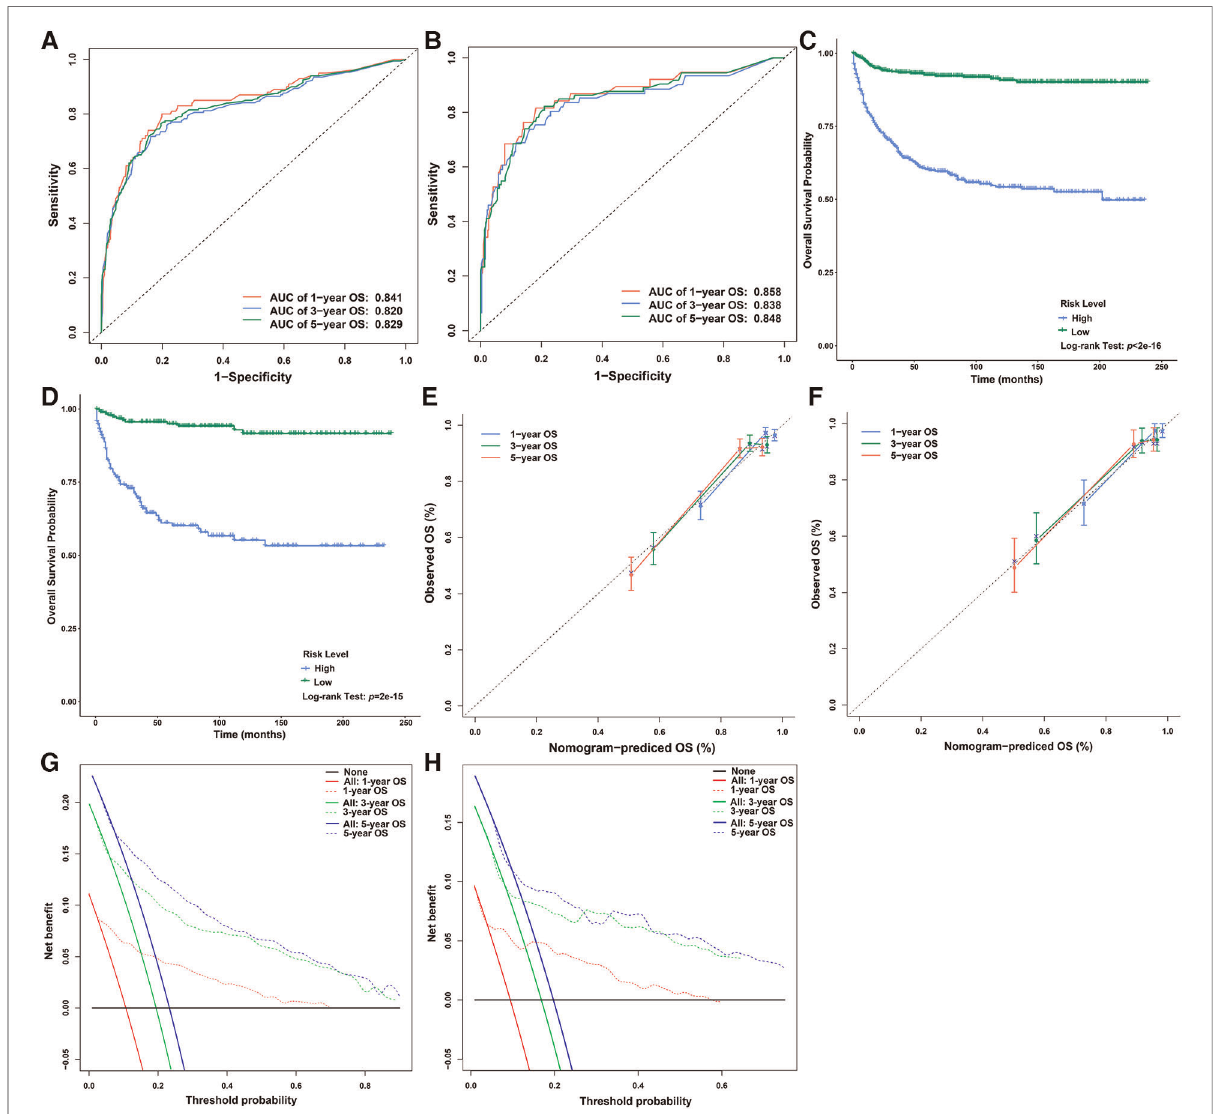
FIGURE 5 Veri fi cation of the nomogram for predicting the OS of children with liver cancer. ( A ) ROC curves of the 1-, 3-, and 5-year OS in the overall dataset. ( B ) ROC curves of the 1-, 3-, and 5-year OS in the testing dataset. ( C ) Survival curves of children with liver cancer between the high- and low-risk score groups in the overall dataset. ( D ) Survival curves of children with liver cancer between the high- and low-risk score groups in the testing dataset. ( E ) Calibration plots of the 1-, 3-, and 5-year OS in the overall dataset. ( F ) Calibration plots of the 1-, 3-, and 5-year OS in the testing dataset. ( G ) DCA plots of the 1-, 3-, and 5-year OS in the overall dataset. ( H ) DCA plots of the 1-, 3-, and 5-year OS in the testing dataset. DCA, decision curve analysis; ROC, receiver operating characteristic curve; OS, overall